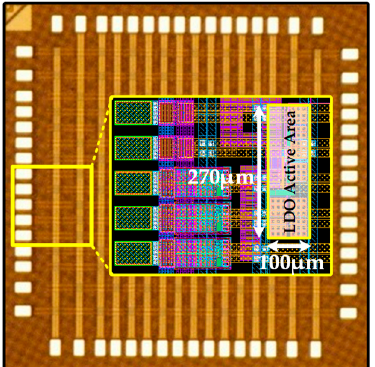
Figure 12. Micrograph of proposed LDO regulator.